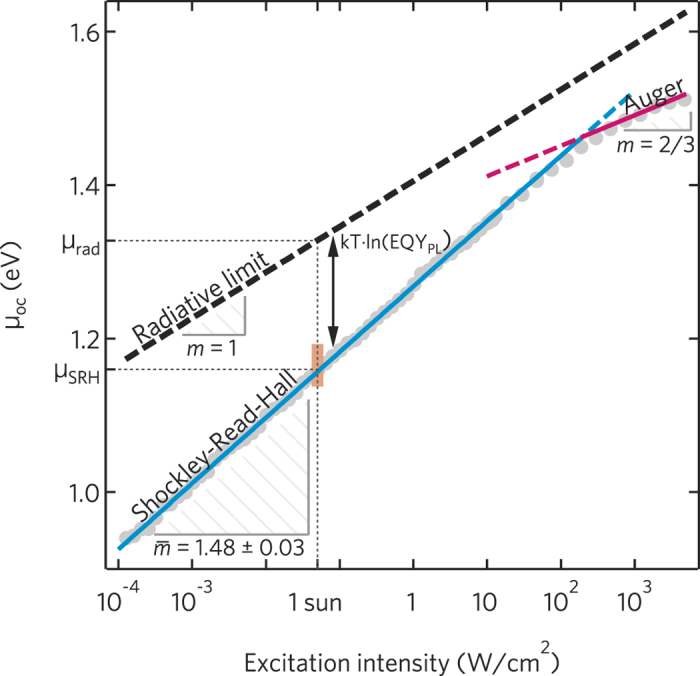
μ -Iex characteristics of intrinsic MAPbI3 films.Grey markers represent the measured free energy μoc as a function of the excitation intensity (Iex) delivered by a CW laser at 532 nm. The orange box encloses the dispersion of μoc for samples fabricated with a variety of different techniques. For 1 mW/cm2 < Iex < 100 W/cm2, μoc depends linearly on ln(Iex) with a slope m of approximately 3/2 regardless of the fabrication method, yielding an average ideality factor  (within one standard deviation). Shockley-Read-Hall recombinations are expected to lead to a rational ideality factor m = 3/2 at low illumination levels. The experimental slope decreases to approximately 2/3 for Iex > 100 W/cm2, as foreseen for Auger recombination. At Iex = 50 mW/cm2, the rate of photons absorbed by the film matches that one obtained at an illumination level of one sun (AM 1.5G). At this excitation intensity, μrad = 1.33 eV while  eV, with a free energy loss due to Shockley-Read-Hall recombinations .